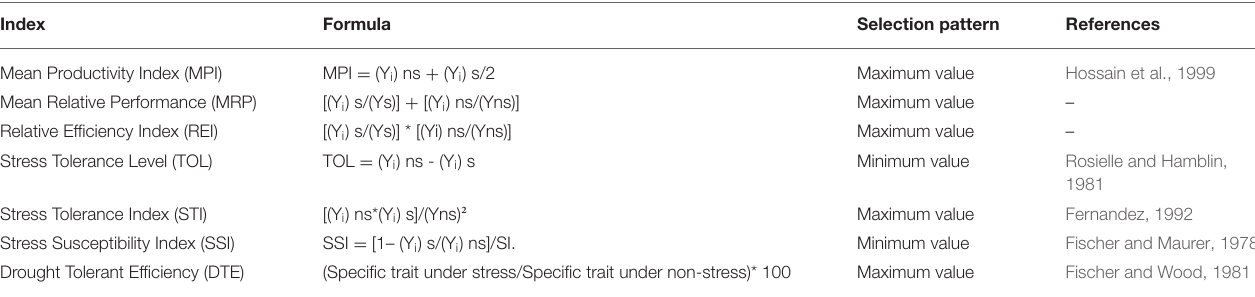
TABLE 1 | Tolerance and susceptibility indices formula used in this